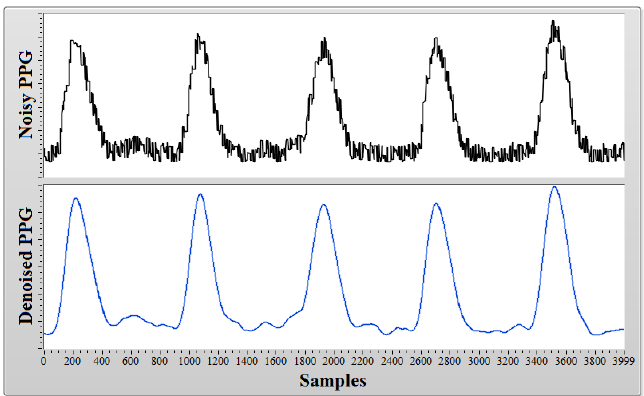
Figure 3. A noisy PPG signal ( Top ) and its denoised version ( Bottom